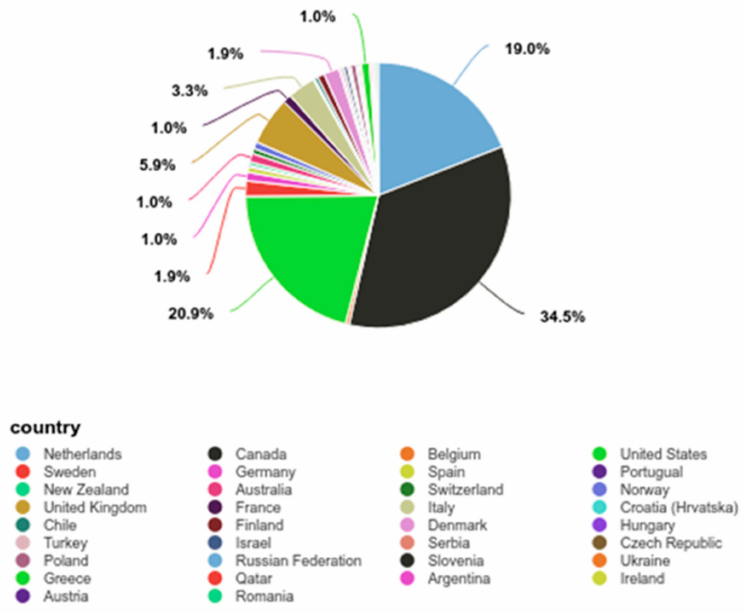
Figure 1. Participation by